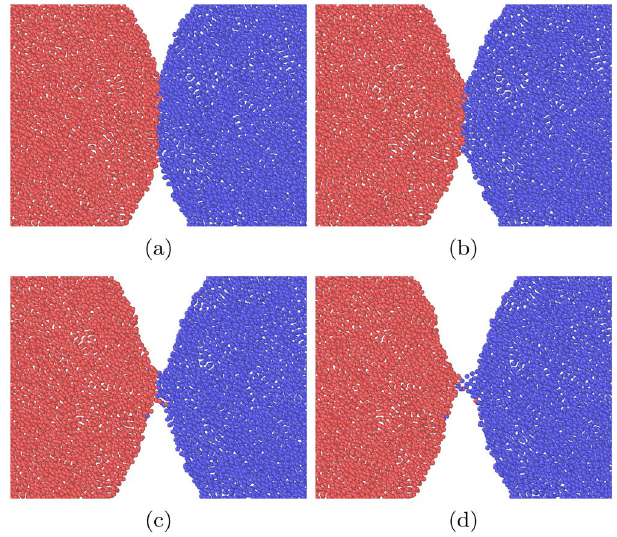
Figure 4. Snapshots of a separation simulation with ǫ 12 = 0.75 for an initial value of the relative velocity v = 0.247 . Snapshots are spaced by (cid:31) t = 9.3 . In all subpanels, the grains are aligned such that the central axis lies horizontally in the middle of the figure.